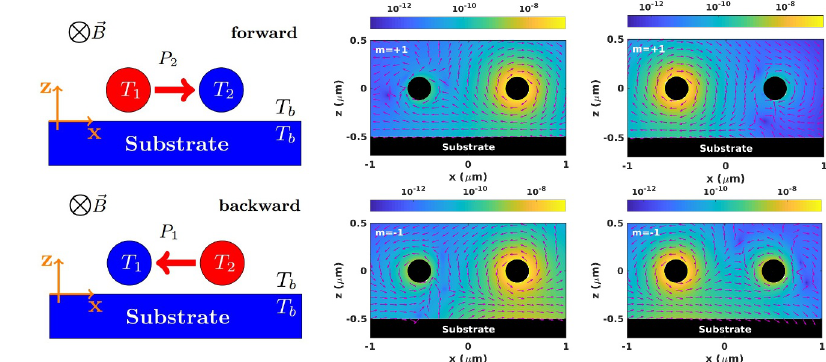
Figure 1. Directional heat flux in forward and backward direction due to the coupling of the m = ± 1 resonances with the spin-momentum locked non-reciprocal surface modes for